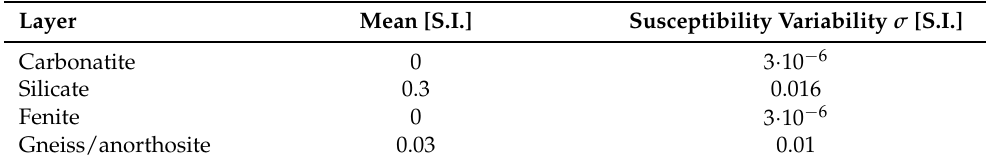
Table 2. A-priori model in terms of magnetic susceptibility, expressed as average values and variability. Layer Mean